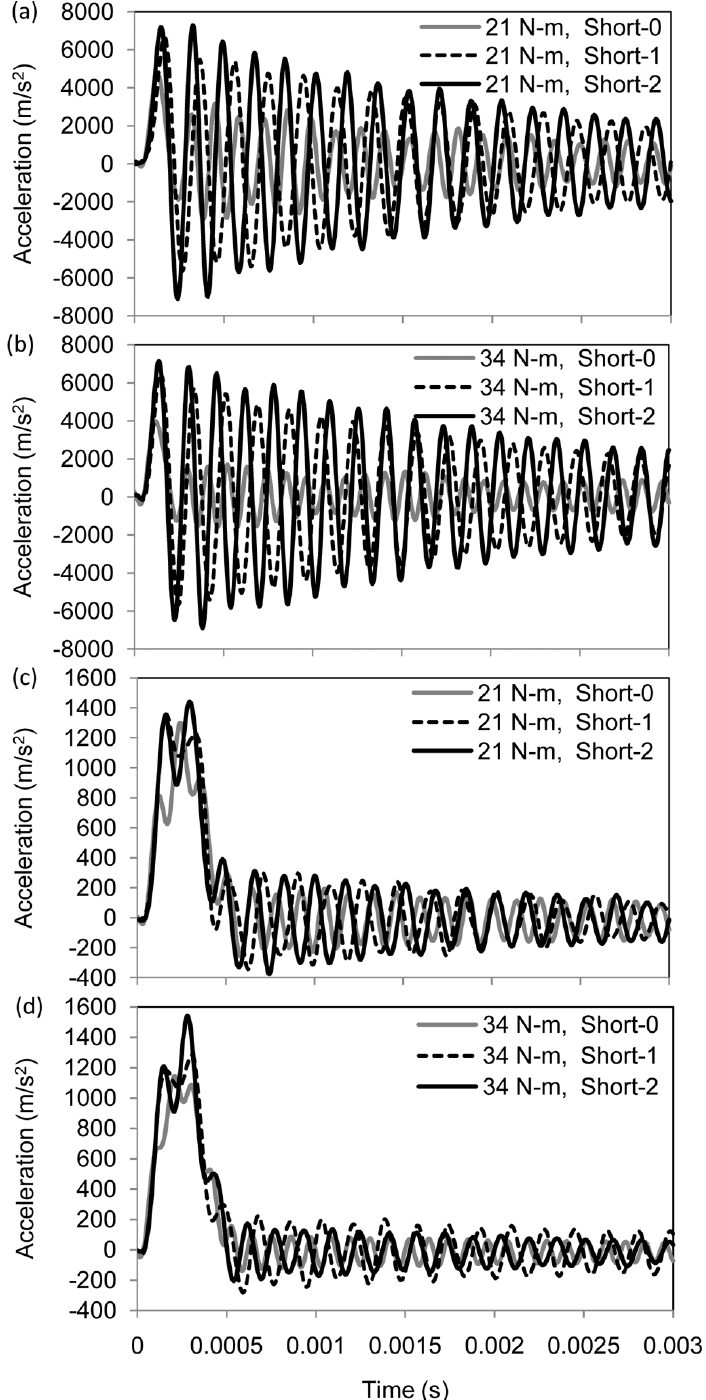
Fig. 8. Experimental results of acceleration response of short structures. (a) the hard tip with bolt tension of 21 N-m, (b) the hard tip with bolt tension of 34 N-m, (c) the medium tip with bolt tension of 21 N-m and (d) the medium tip with bolt tension of 34 N-m. 10,000 Hz cutoff frequency is used for low-pass fi